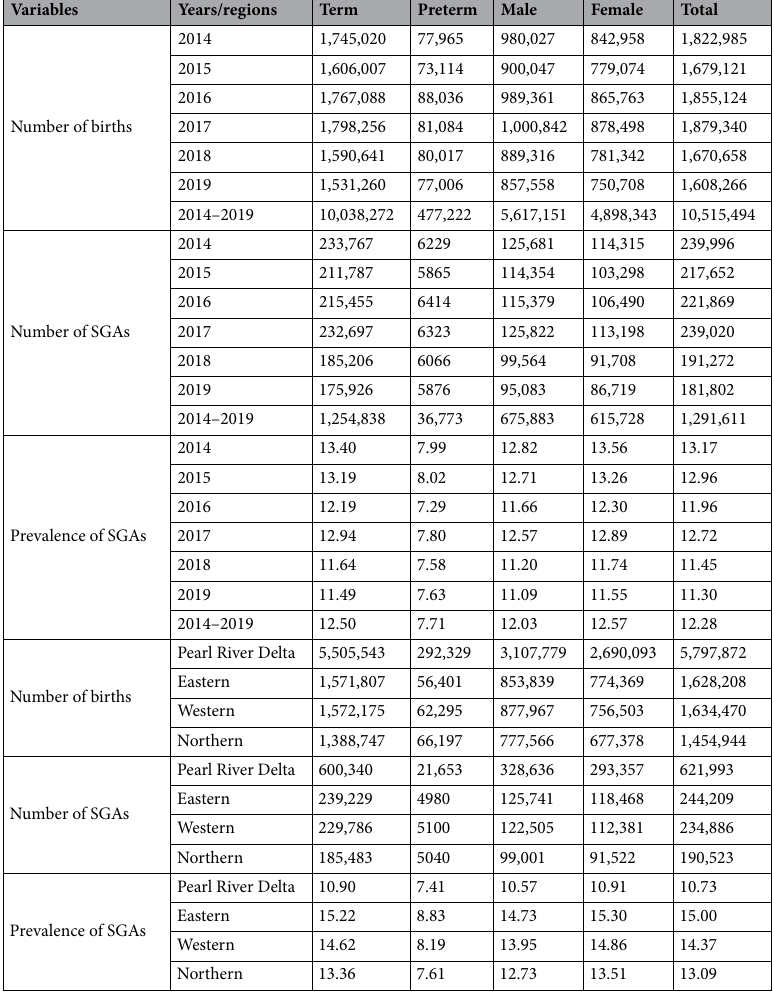
Table 1. Prevalence of SGA (per 100 infants) in Guangdong province, China, 2014–2019. SGA : small for gestational